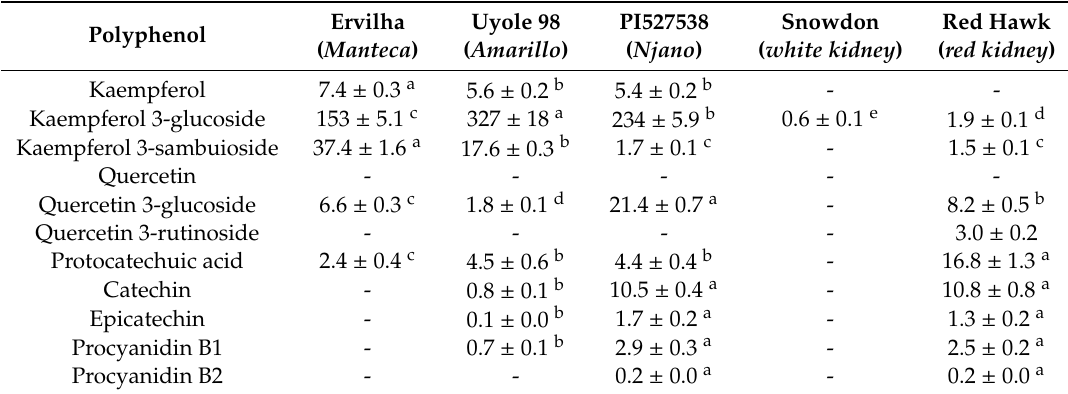
Table 5. Polyphenol Concentrations (nmol / g) Measured in Bean Based Diets. 1 .